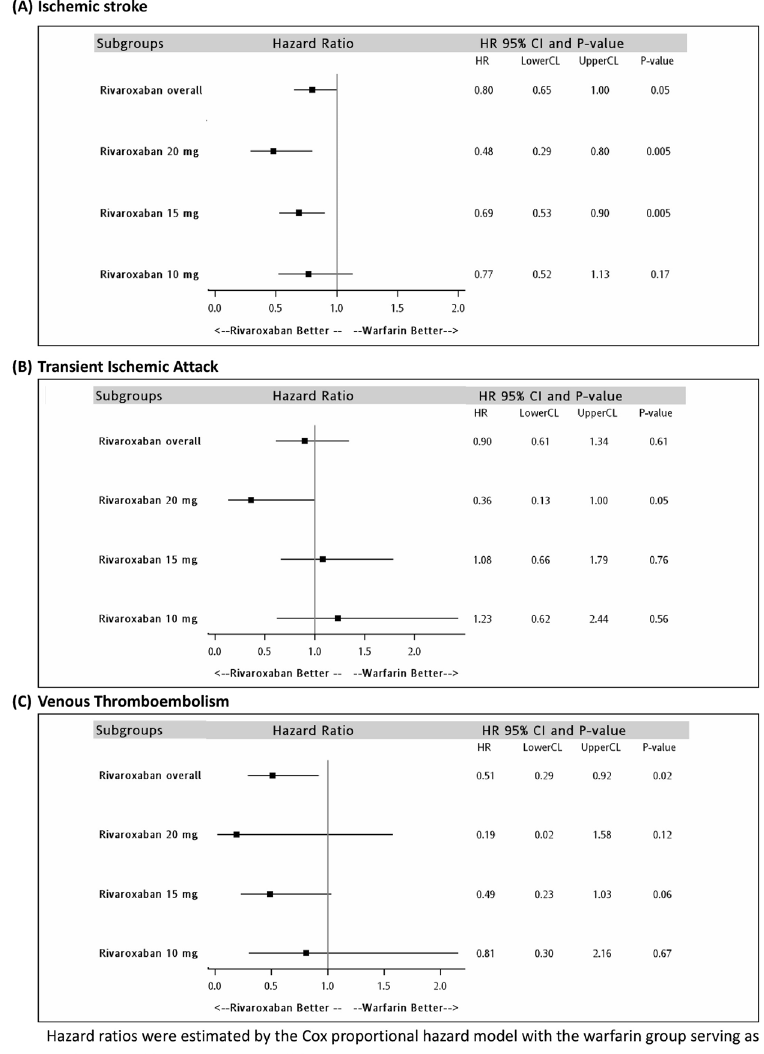
Figure 1. Comparisons of the effectiveness outcomes among different dose regimens in the rivaroxaban